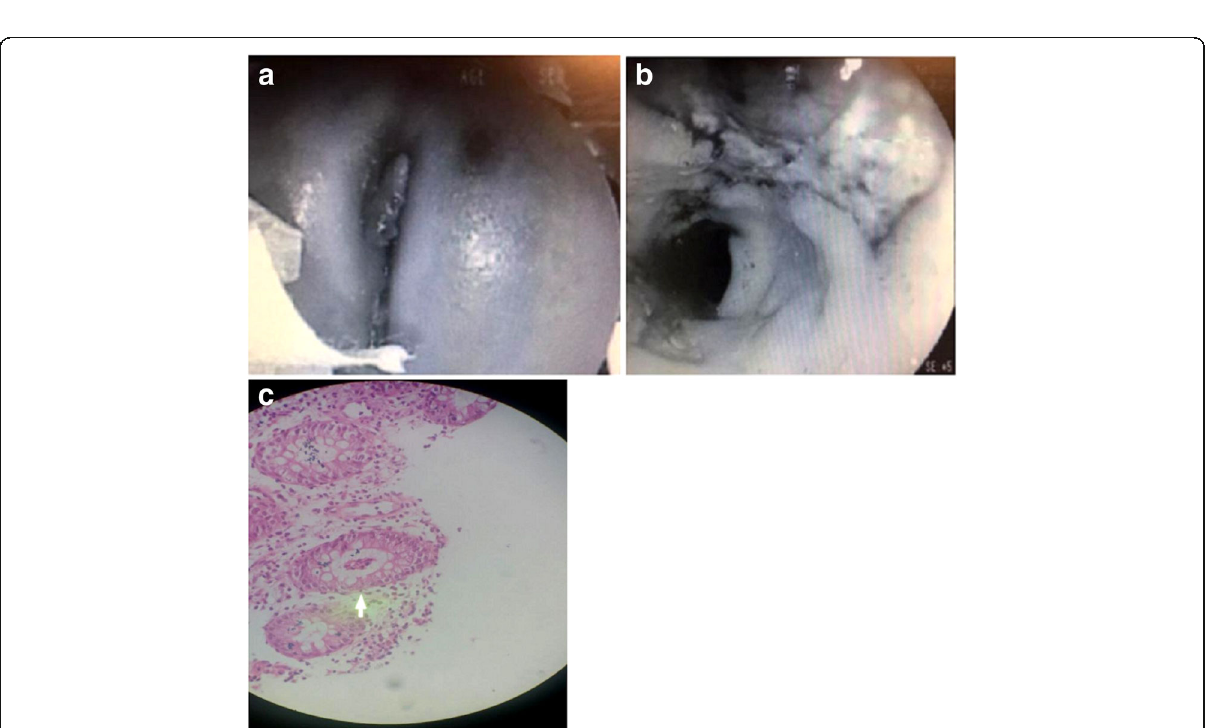
Fig. 1 Sigmoidoscopy study in the proband. a . It is shown severe and diffused ulcer, polypoid lesion and decreased vascularity in rectum. b. Colon and rectum biopsy revealed chronic colitis. c . The histological section from colon and rectum showed cryptitis and crypt abscesses